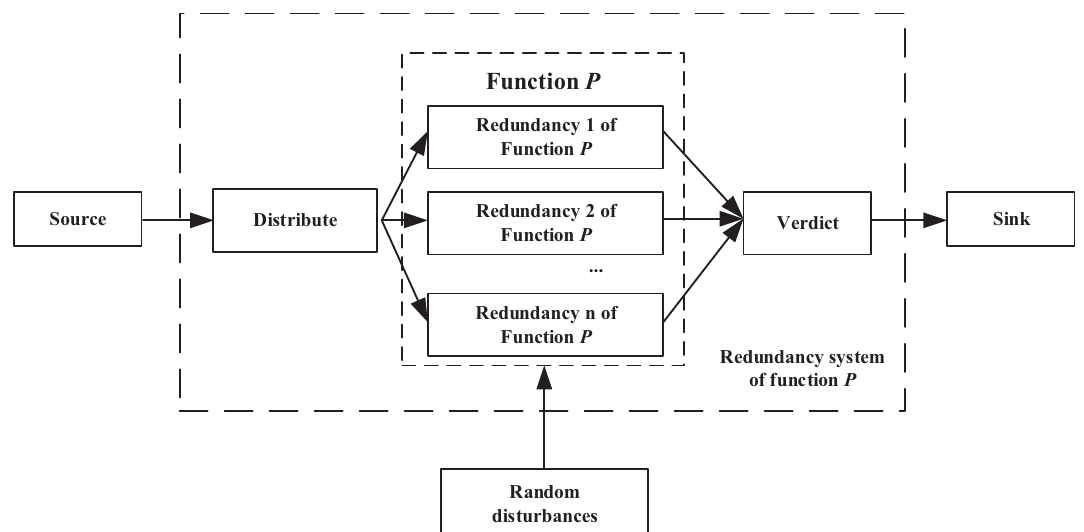
Figure 5. Typical model for reliability assurance